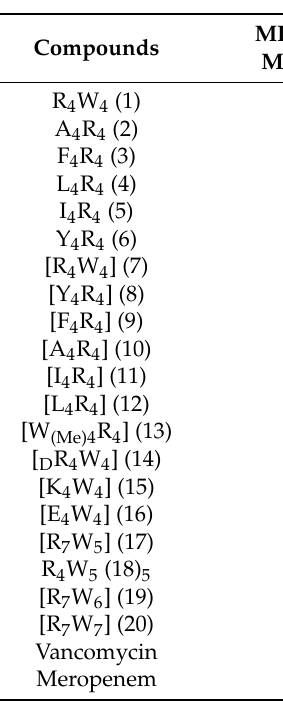
Table 1. Antibacterial assay against Gram-negative and Gram-positive